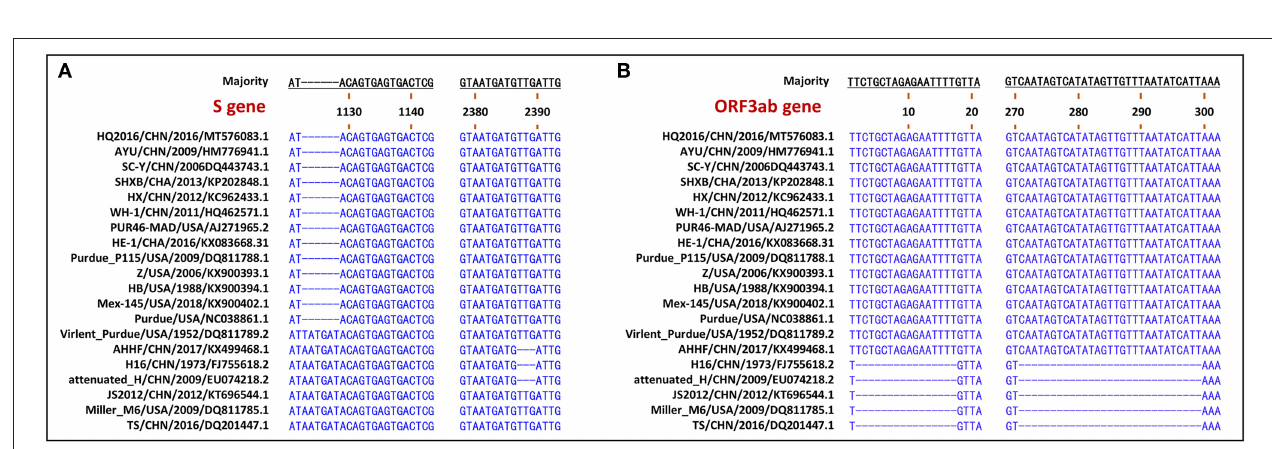
FIGURE 2 | Visualization of genomic deletion regions in the 20 TGEV strains. (A) deletion regions of S gene. (B) deletion regions of ORF3ab